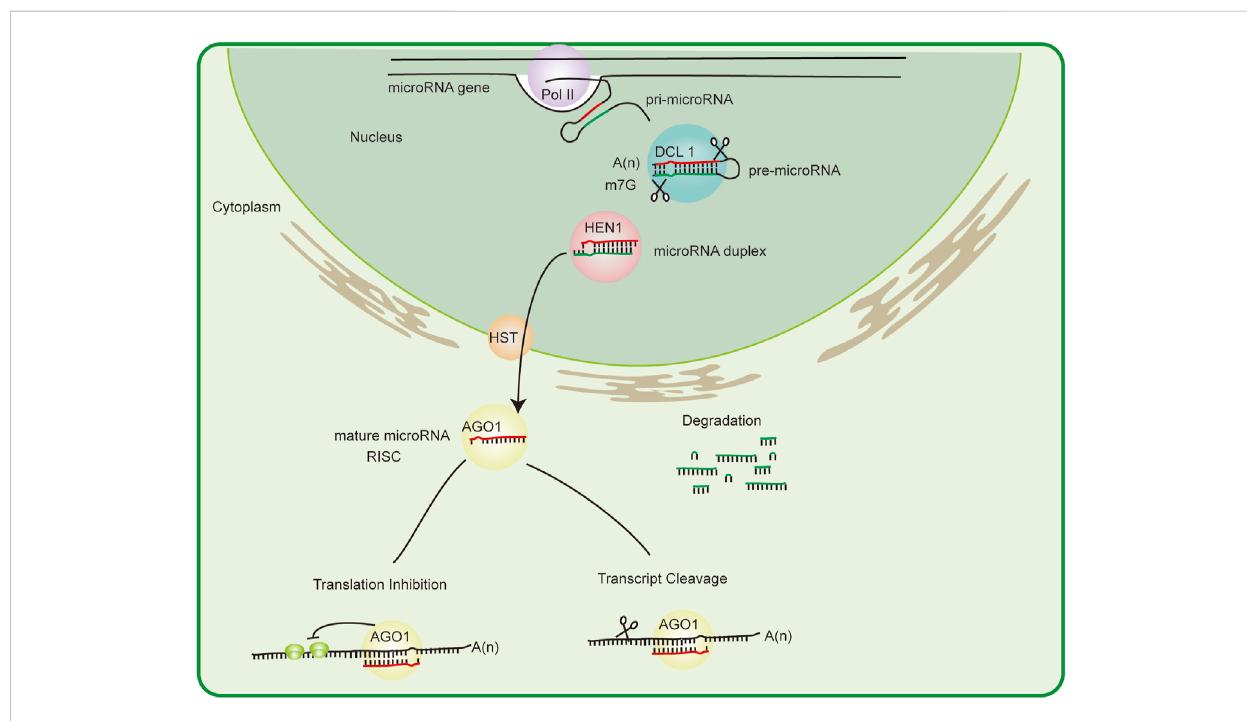
FIGURE 1 MicroRNA biogenesis and mechanism. The pathway of microRNA biogenesis in plants is shown. pri-microRNA is the primary transcript. The stem – loopstructureofpri-microRNAissplitinthenucleusbyDCL1toformamaturetranscript.Aredstrand(microRNA)andagreenstrand(microRNA*) are generated. MicroRNA isstabilizedbyHEN1 methylation before beingexportedto thecytoplasmby HST.The red strand isintegrated into miRISC, and thegreenstrandisdegraded.Dependingonthedegreeofcomplementaritywiththetargetsite,miRISCcleavesmRNA,therebyinducingimmediate degradationorinhibitingthetranslationprocess.AGO,Argonaute;DCL,Dicer-likeprotein;HEN1,HUAENHANCER1;HST,HASTY;pri-microRNA,primary